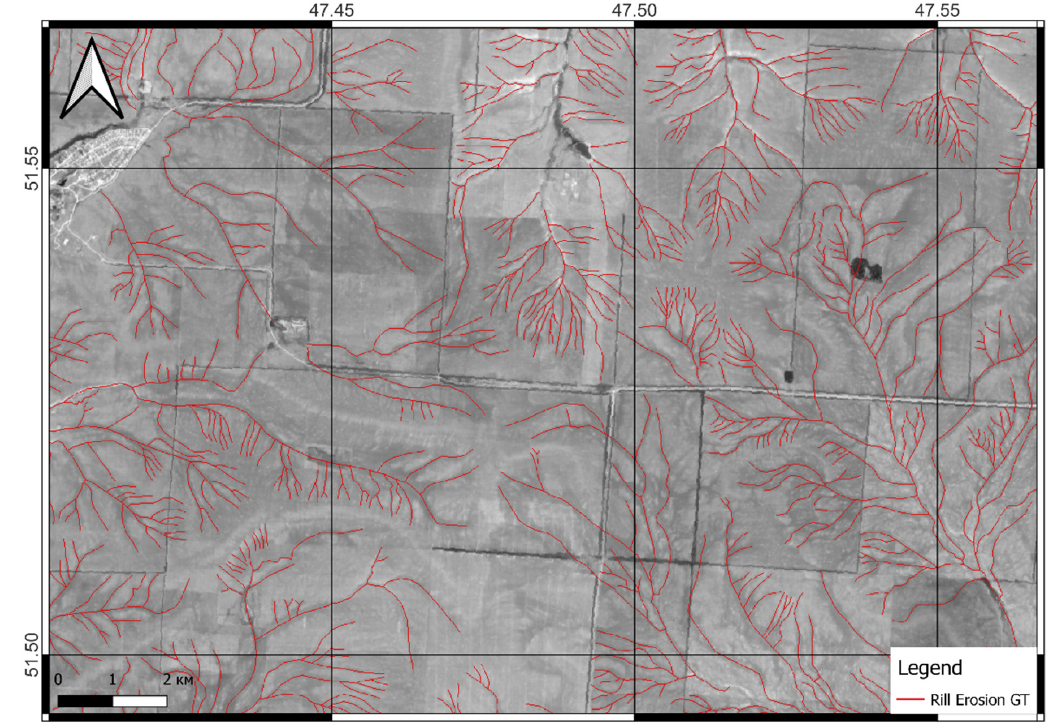
Figure 2. Fragment of a rill erosion ground truth data (GT).